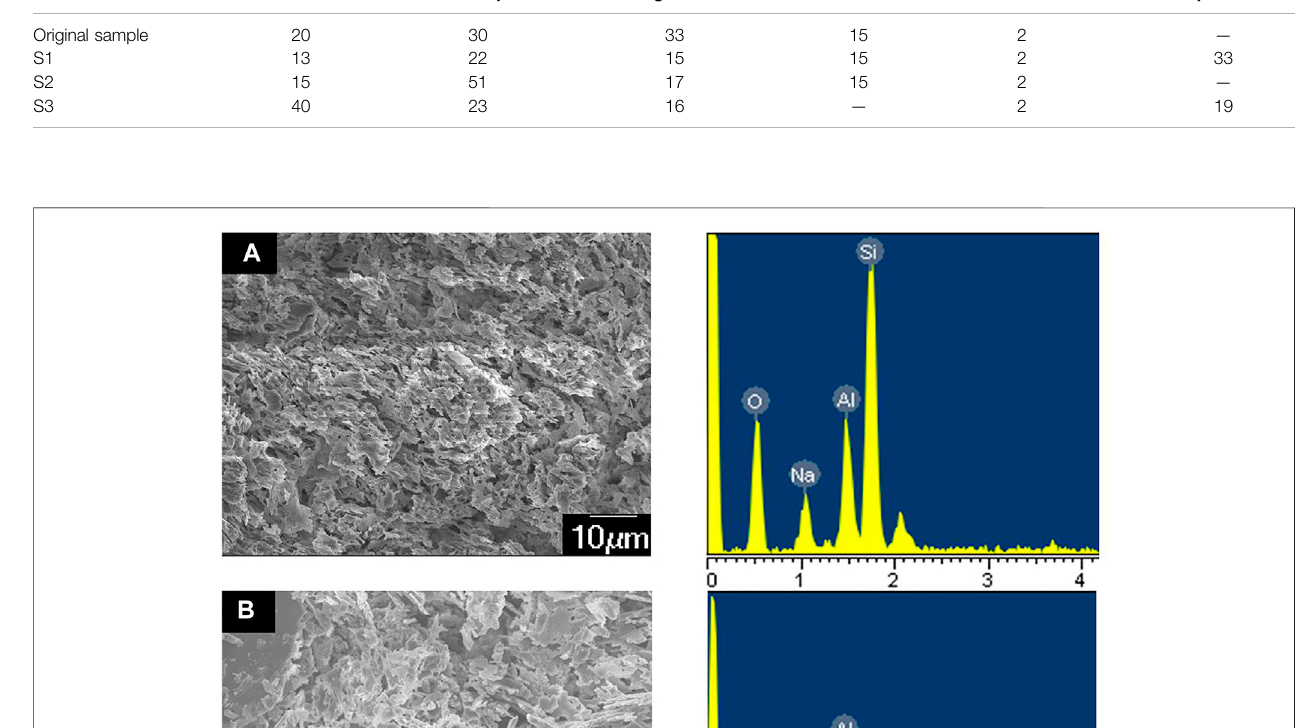
Frontiers in Earth Science |